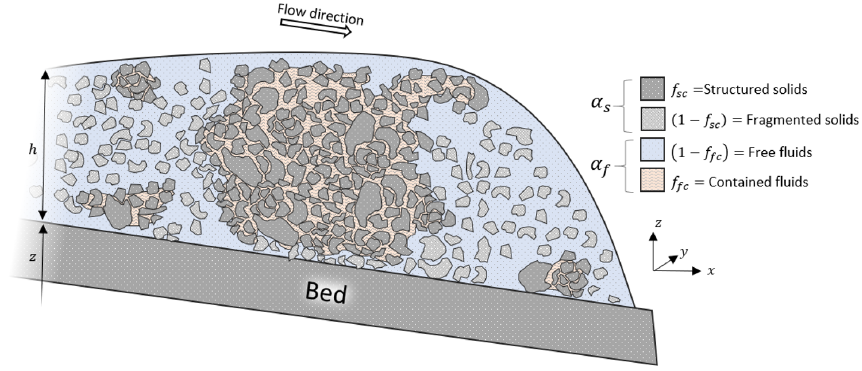
Figure 1. A schematic depiction of the flow contents. Both structured and unstructured solids are present. Fluids can be either free or confined by the structured